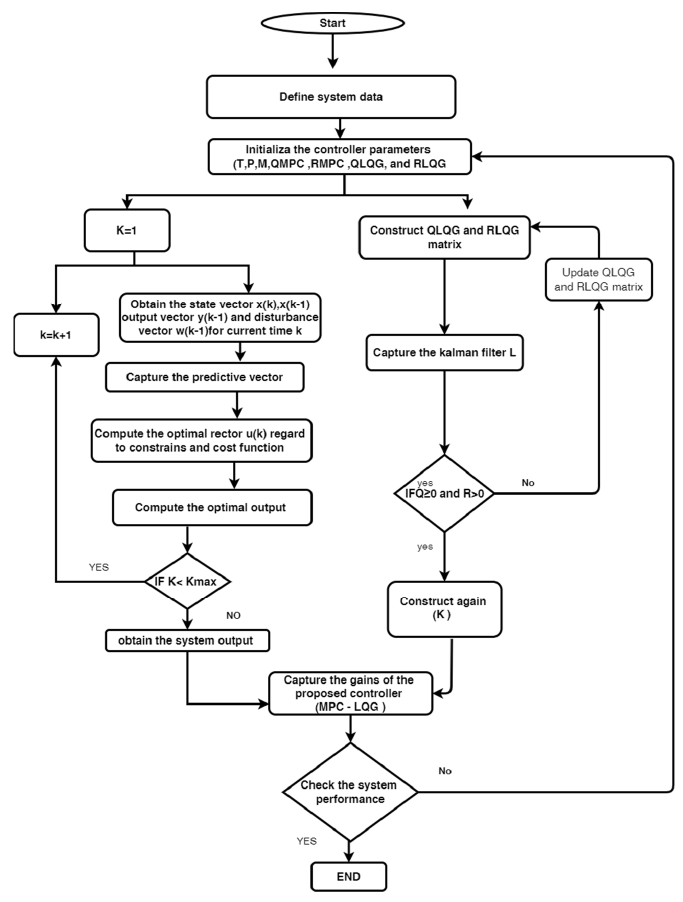
Figure A2. flow chart of LQG-MPC cotroller [31]. Figure A2. Flow chart of LQG-MPC cotroller